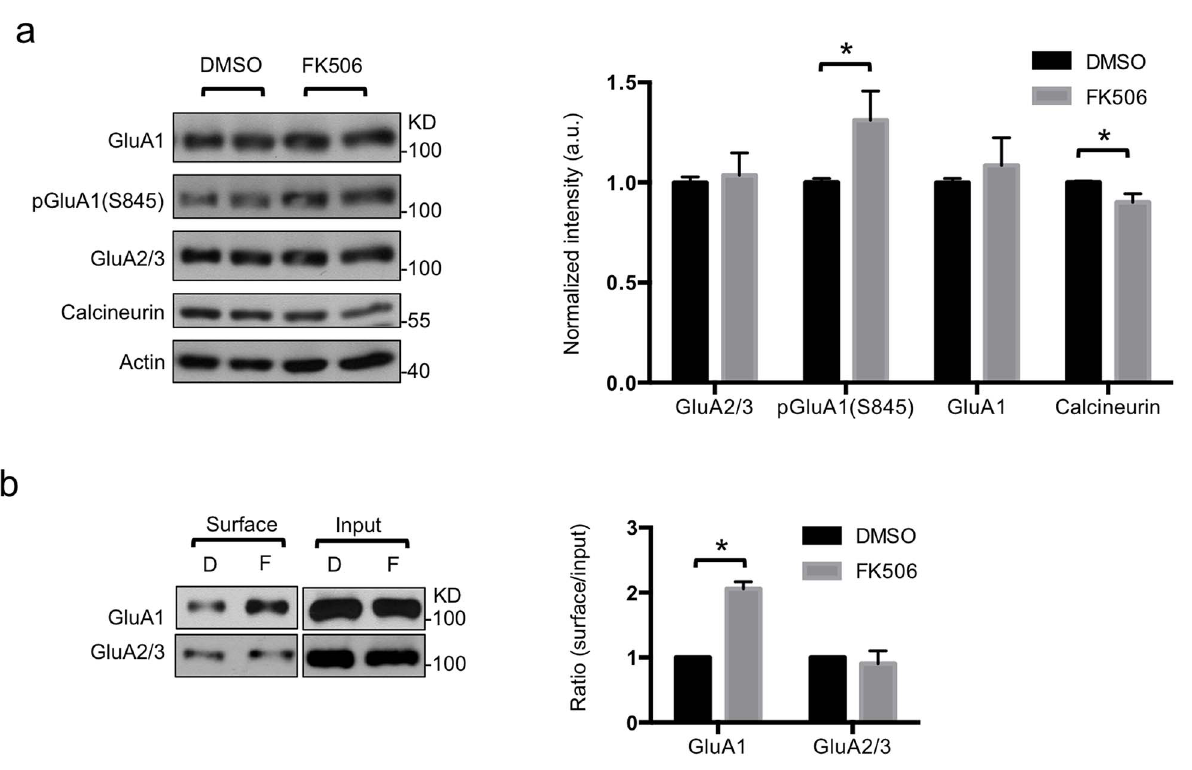
Figure 5. Inhibition of calcineurin activity increased GluA1 surface trafficking by phosphorylation but decreases calcineurin. (a) Representative immunoblots and quantitative analysis of synaptosomes from cultured cortical neurons in the presence and absence of FK506 treatment ( n =5 experiments, * p , .05, unpaired two-tailed Student’s t test). (b) Representative immunoblots of surface biotinylation (D, DMSO; F, FK506) and a summary graph in the presence or absence of FK506 treatment ( n =6 experiments, * p , .05, unpaired two-tailed Student’s t